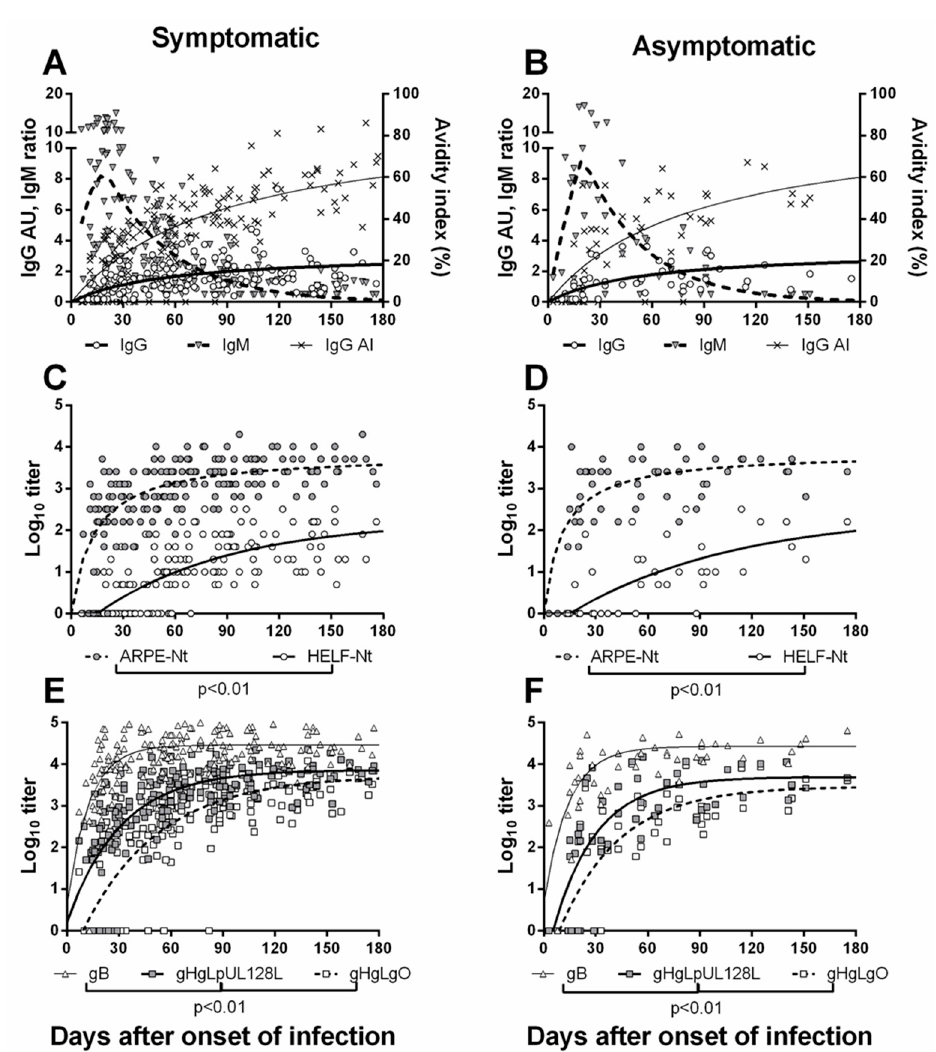
Figure 3. Antibody kinetics according to different serological assays during the first 180 days after PI onset in 40 pregnant women with symptomatic (left panel) and 13 pregnant women with asymptomatic (right panel) infection. ( A , B ): HCMV-specific IgG and IgM antibodies and IgG avidity index (AI). ( C , D ): Neutralizing (Nt) antibody titer, as determined in ARPE-19 epithelial cells and HELF cells. ( E , F ): ELISA IgG antibody titer to VR1814 glycoprotein complexes gB, gH/gL/pUL128L and gH/gL/gO [77].